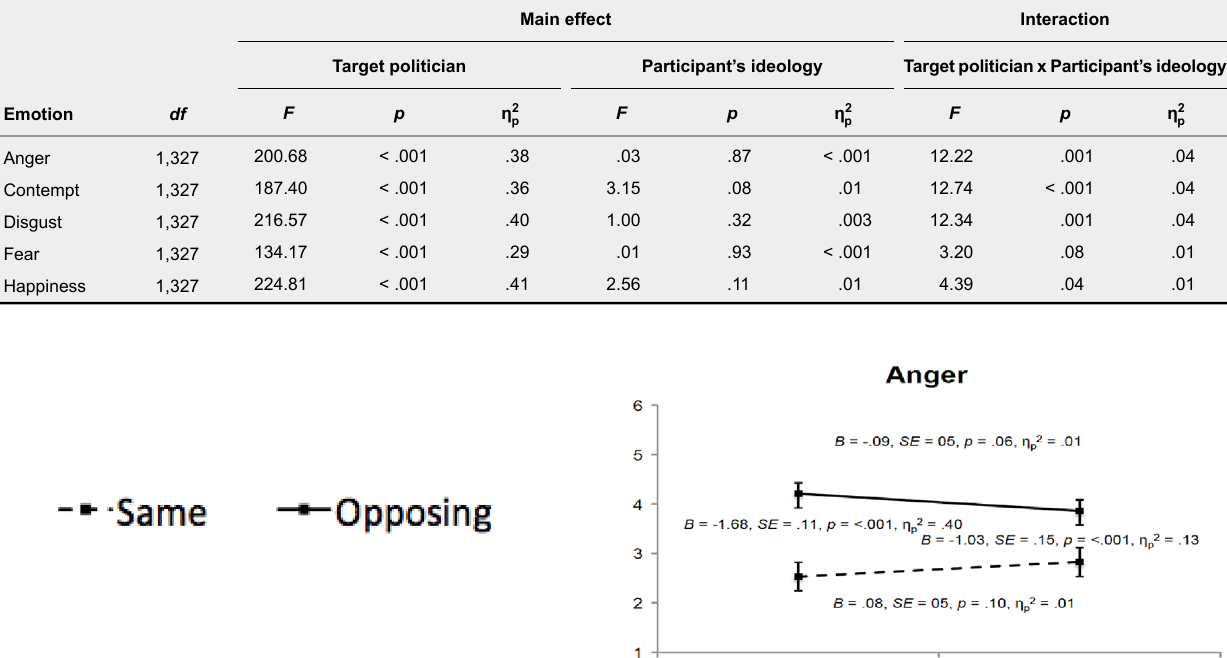
ANOVA Results for Study 2